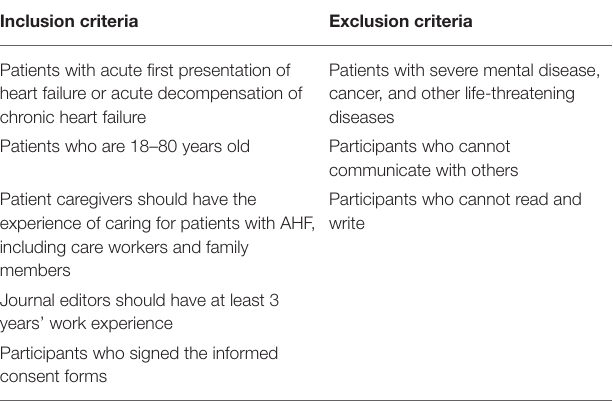
TABLE 5 | The inclusion and exclusion criteria for patients and the public survey. Inclusion